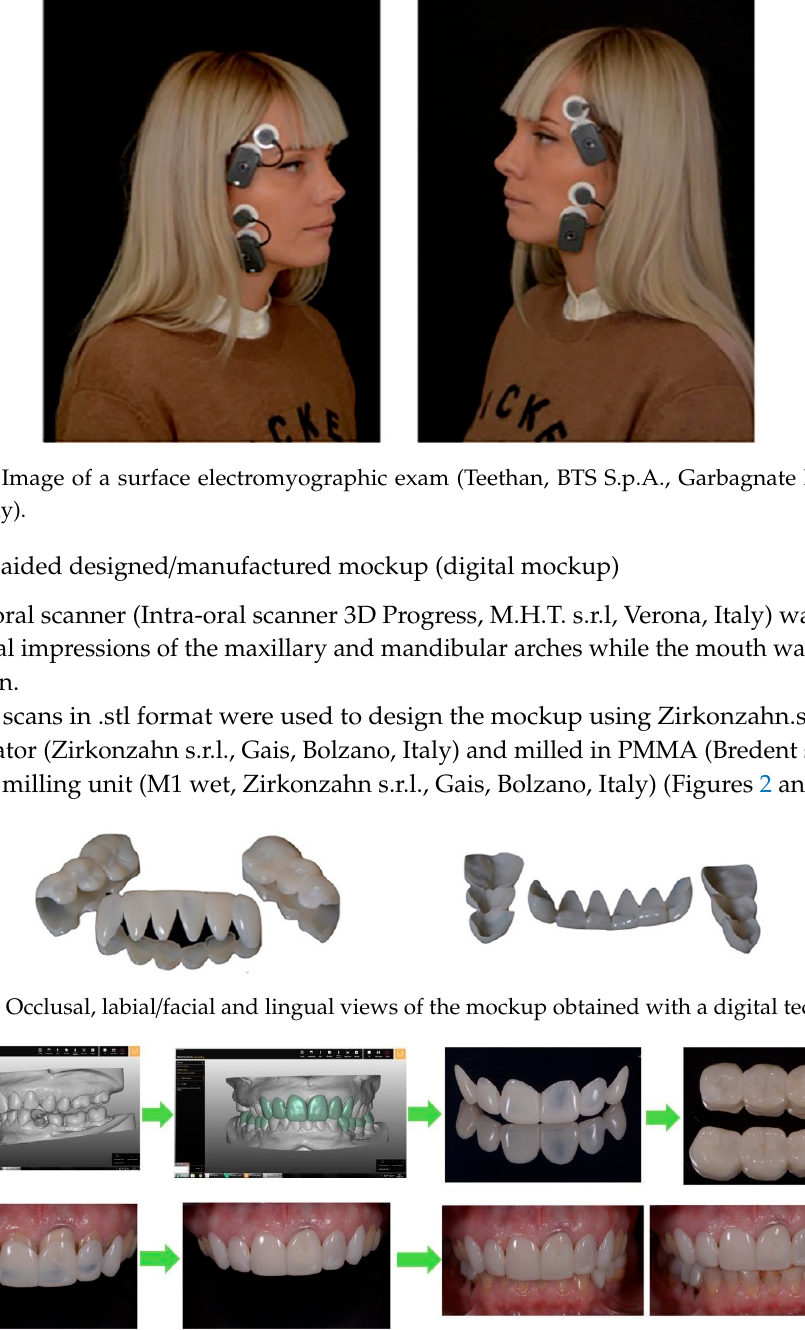
Figure 1. Image of a surface electromyographic exam (Teethan, BTS S.p.A., Garbagnate Milanese, Milan, Italy).